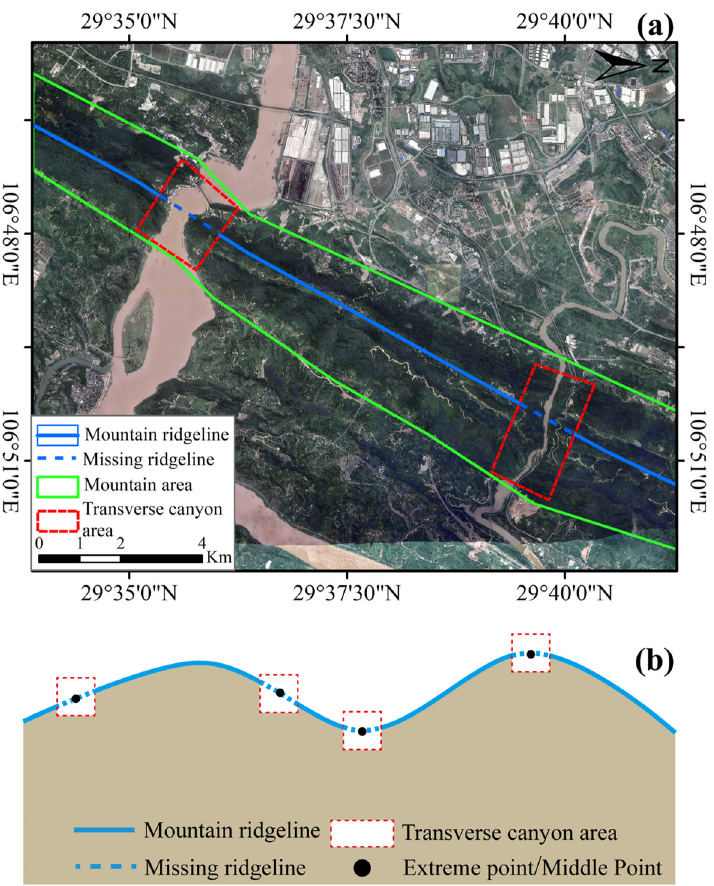
Figure 2. The transverse canyon may be located at different positions on the mountain. ( a ) A mountain range has two transverse canyons in Chongqing, China, observed from remote sensing images (http://www.gscloud.cn/search, (accessed on 6 August 2022). ( b ) The profile along the ridgeline shows the four possible locations of transverse canyons.